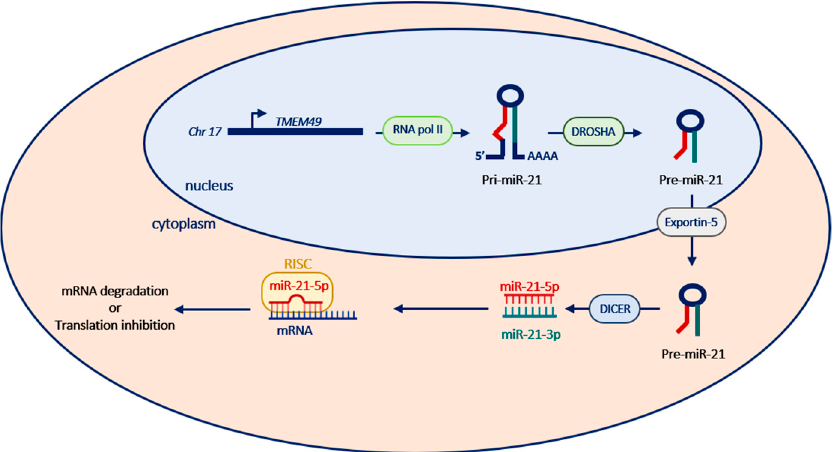
Figure 1. Biogenesis of miR-21. miR-21 is transcribed by RNA polymerase II from chromosome 17 into pri-miR-21 transcript, which is then processed by a microprocessor into hairpin precursor molecules (pre-miR-21) in the nucleus. These are exported to the cytoplasm by exportin 5 and are further processed into mature miR-21 sequences, which are then incorporated into the RISC and guided to miR-21 target mRNAs to repress their expression.